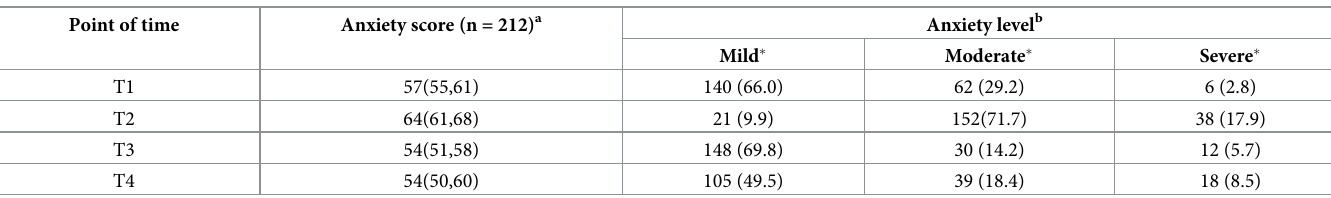
Table 2. Status of peri-procedure anxiety.